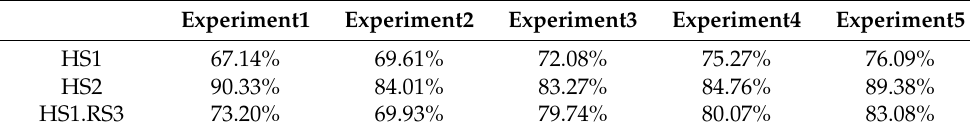
Table 7. Testing accuracy of each group of comparison experiments.